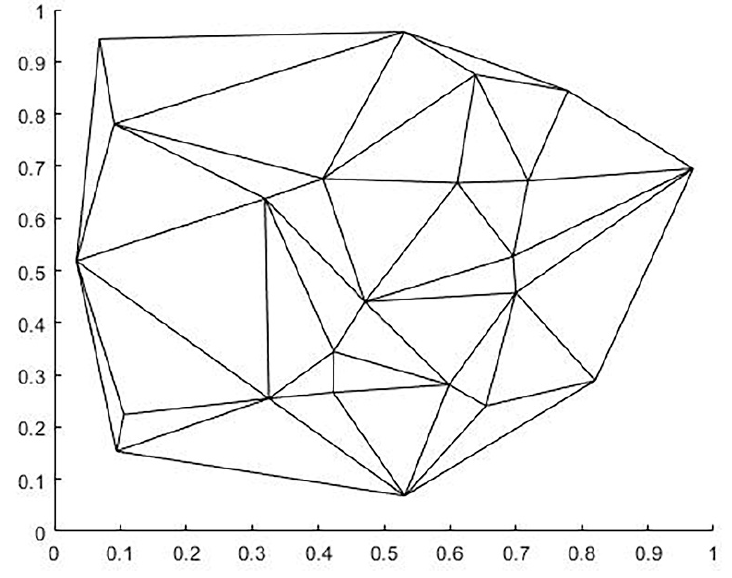
Figure 5. Delaunay Figure 5. Delaunay triangulation.